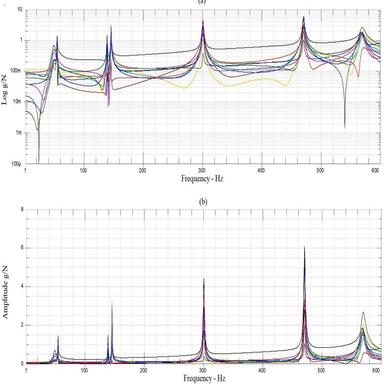
Presentaion of FRF measurements in (a) Logarithmic scale and (b) Linear scale.